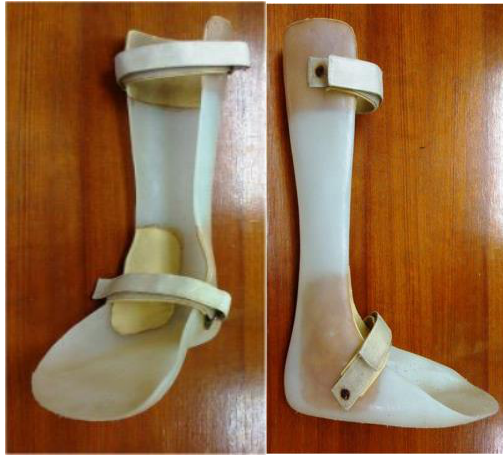
Figure 3. PAFO, posterior ankle foot